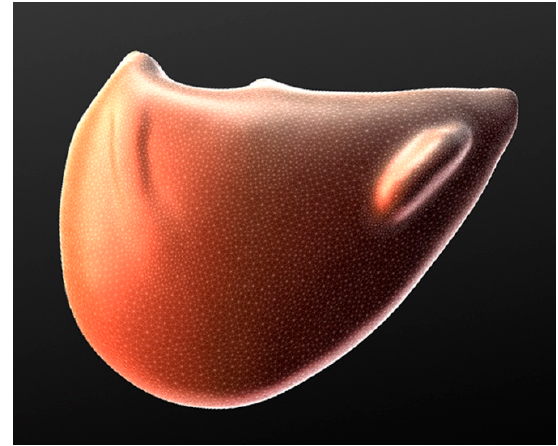
Figure 37. Cambroarchilocus tigris gen. nov. sp. nov. Reconstruction of left valve, anterior to left (shown here without the admarginal rim). Reconstruction based on both the holotype and paratype. Width of shield 1.5 mm. Image Credit: Mark McMenamin, using Scuptris Alpha 6 by Pixologic, Inc.